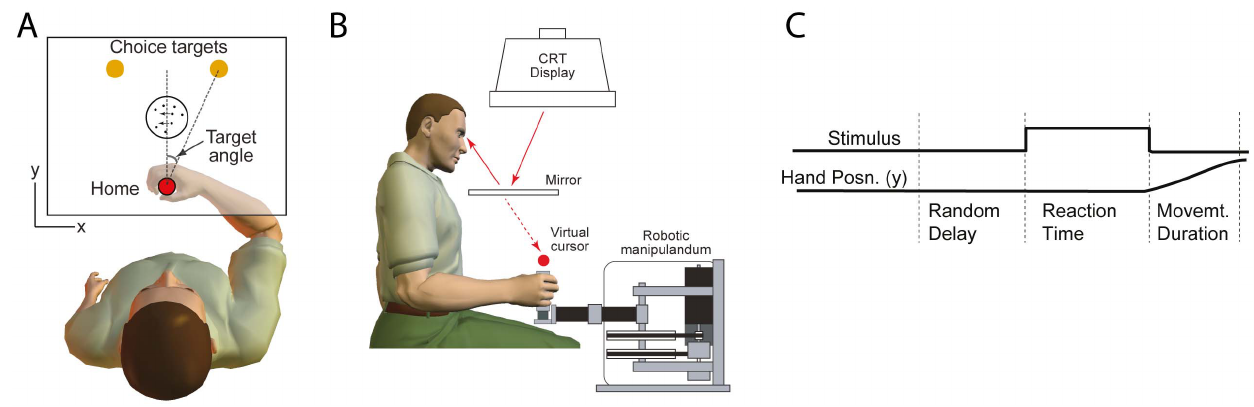
Figure 1. Experimental set-up. A: Schematic of the visual display (rectangle). A trial starts when the subject’s hand is in the home position. After a random delay, the random dot kinematogram become visible and the subject views the moving dot stimulus for as long as they need (up to 2 s). Subjects indicate the direction of dot motion by moving to the leftward or rightward choice target. As soon as the subject moves from the home position, the motion stimulus vanished. The trial ended when the subject reached one of the two choice targets. B: Subjects held the handle of a robotic interface and moved to either a leftward or a rightward circular target depending on the perceived motion direction of a central random-dot display. A mirror system prevented subjects from seeing their arm. C: The time course of events that make up a trial.